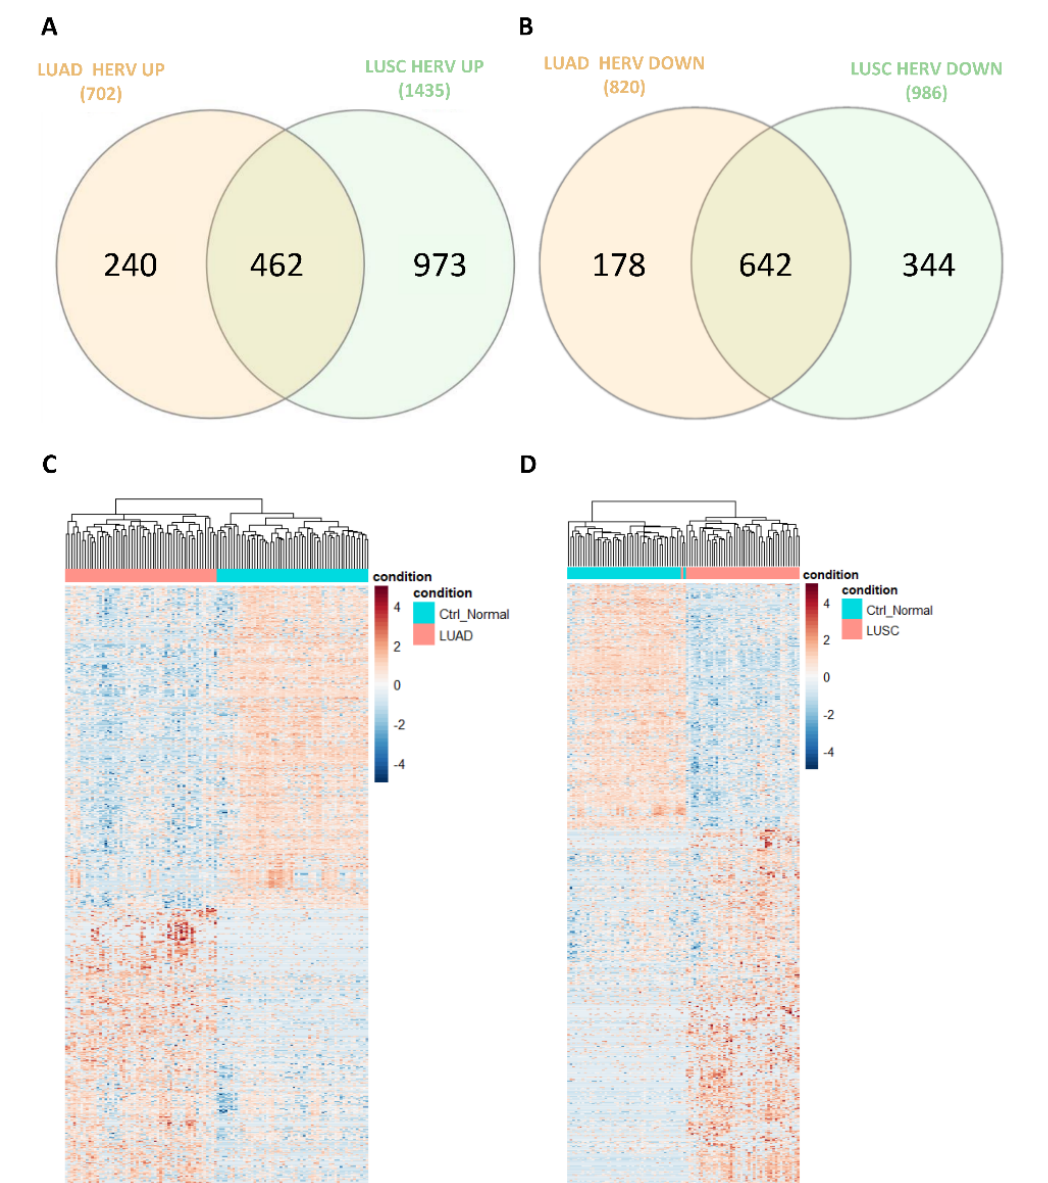
(Figure 3C,D). The differential HERV expression analysis results for LUAD and LUSC can be found in Supplementary File S4.